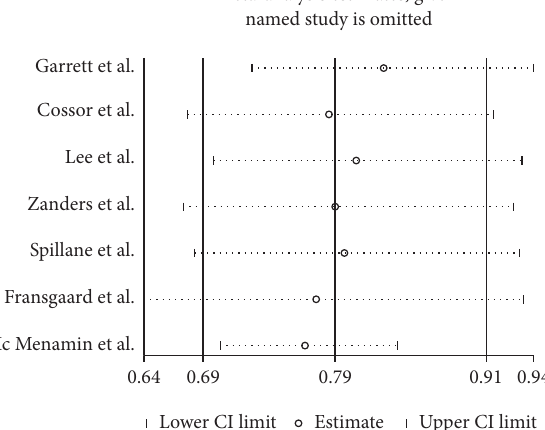
Figure 5: Sensitivity analysis by excluding one study each time and the pooling estimate for the rest of the